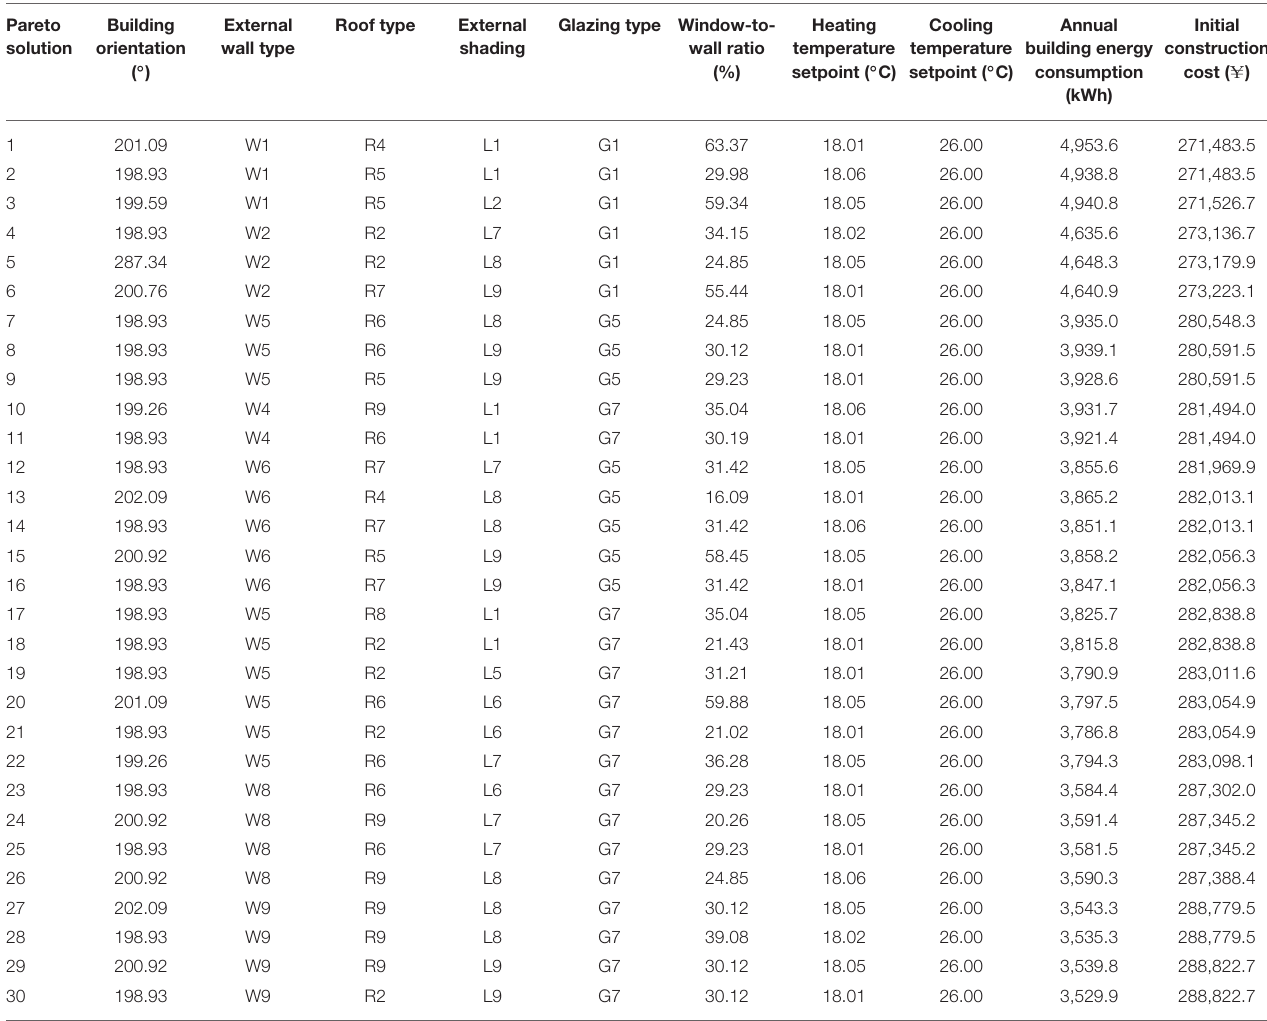
TABLE 7 | 30 sets of Pareto solutions randomly selected for Wuhan considering the trade-offs between annual energy consumption and initial construction cost. Pareto